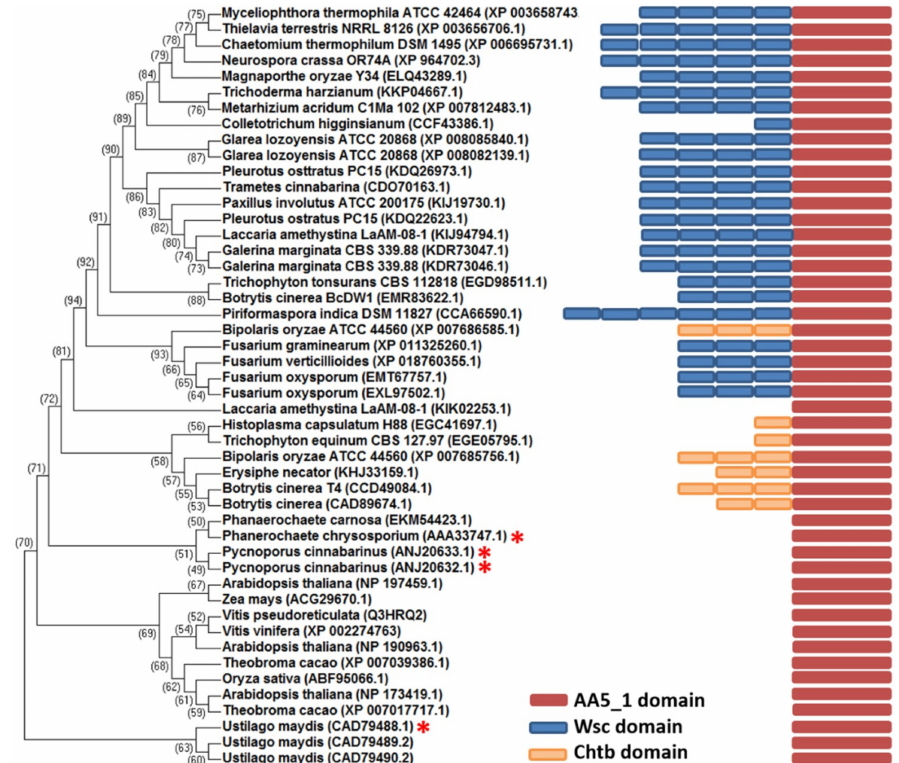
Figure 1. Domain organization of glyoxal oxidases. Phylogenetic tree of predicted AA5 domains of glyoxal oxidase (GLOx) enzymes. The N-terminal Wall Stress-responsive Component (WSC)/Chtb domains were removed to avoid alignment bias. Muscle alignment and tree constructed using MEGA are shown. The GLOx domains were annotated using the CDD (Conserved Domain Database) tool in NCBI. The bootstrap values are indicated on the nodes based on 1000 trials. The asterisk indicates the characterized